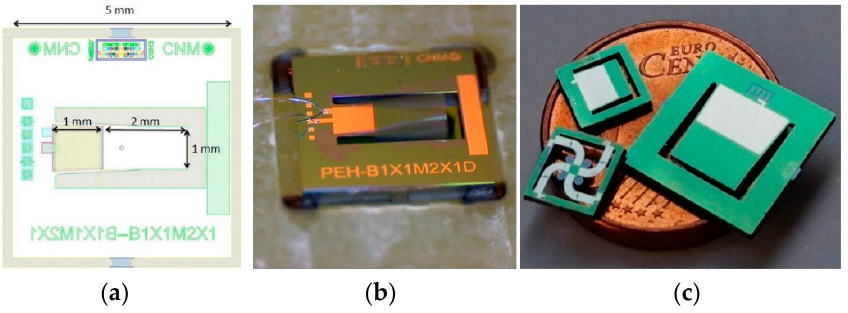
Figure 1. ( a ) Diagram and size of a piezoelectric microgenerator (5 mm × 5 mm × 0.516 mm); ( b ) Manufactured piezoelectric microgenerator at resonance; ( c ) Different designs of manufactured piezoelectric microgenerators.